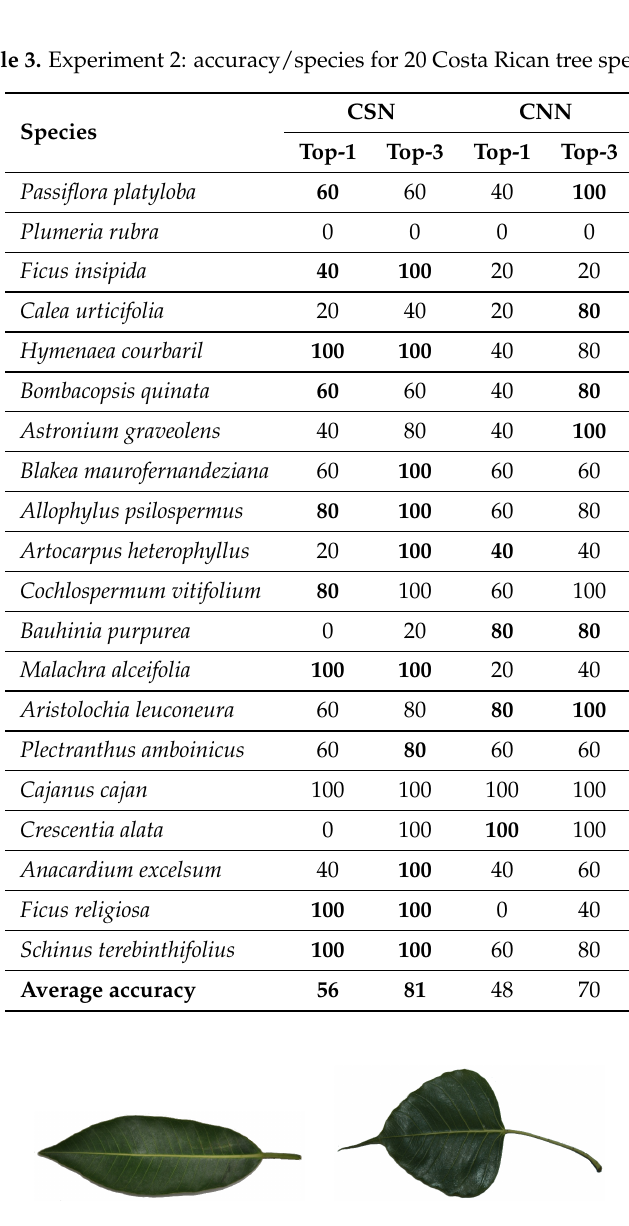
Figure 11. Ficus religiosa and Ficus insipida